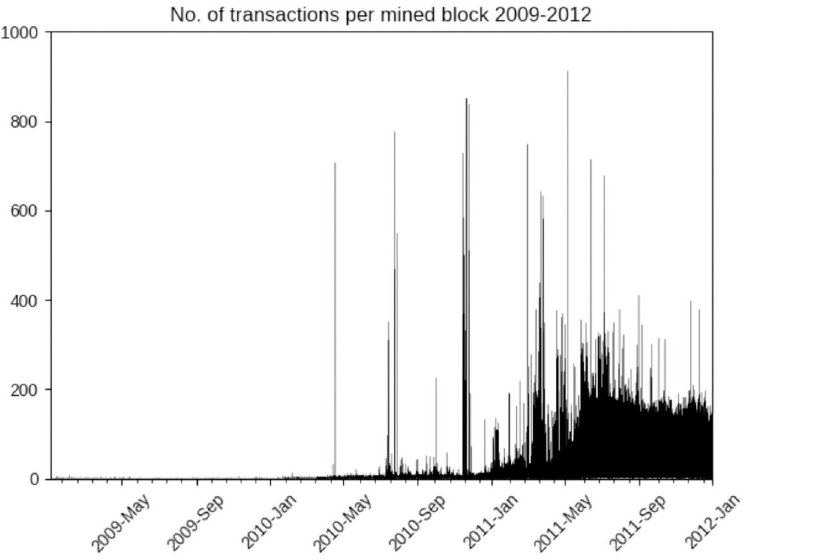
Fig 7. Average number of transactions/block mined between 2009-2011.